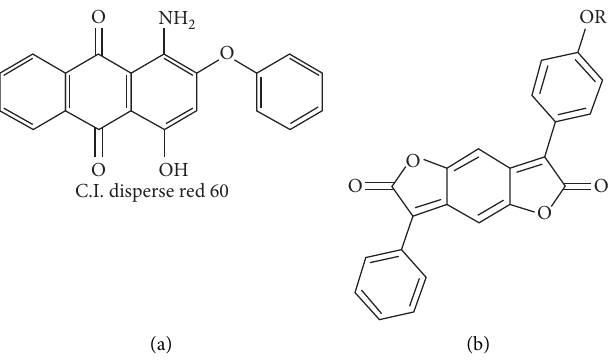
Figure 4: (a) Disperse red 60 and (b) the benzodifuranone dye